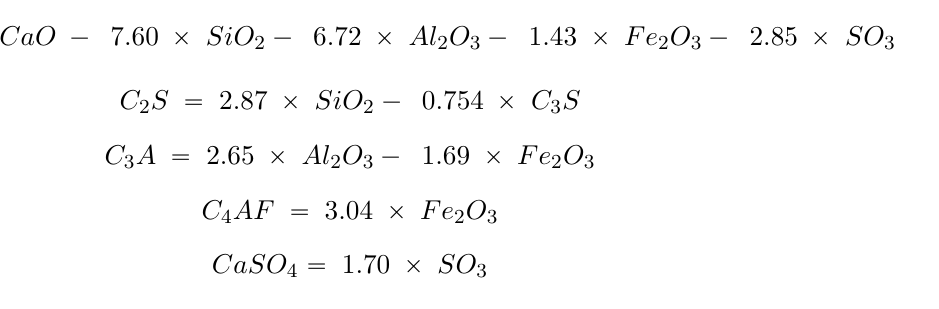
Table 8. Chemical compositions of the cement clinker and recycled cement. Compositions Cement-Clinker Recycled